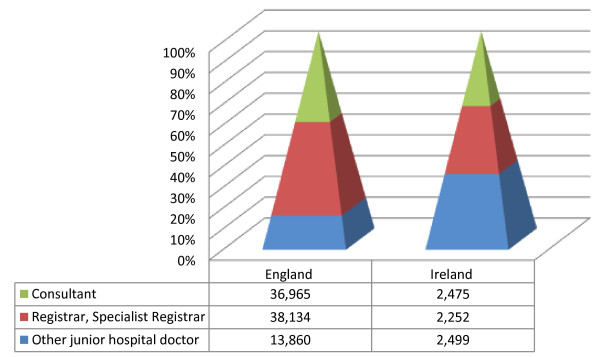
Medical posts in England and Ireland, 2011 [24],[25].